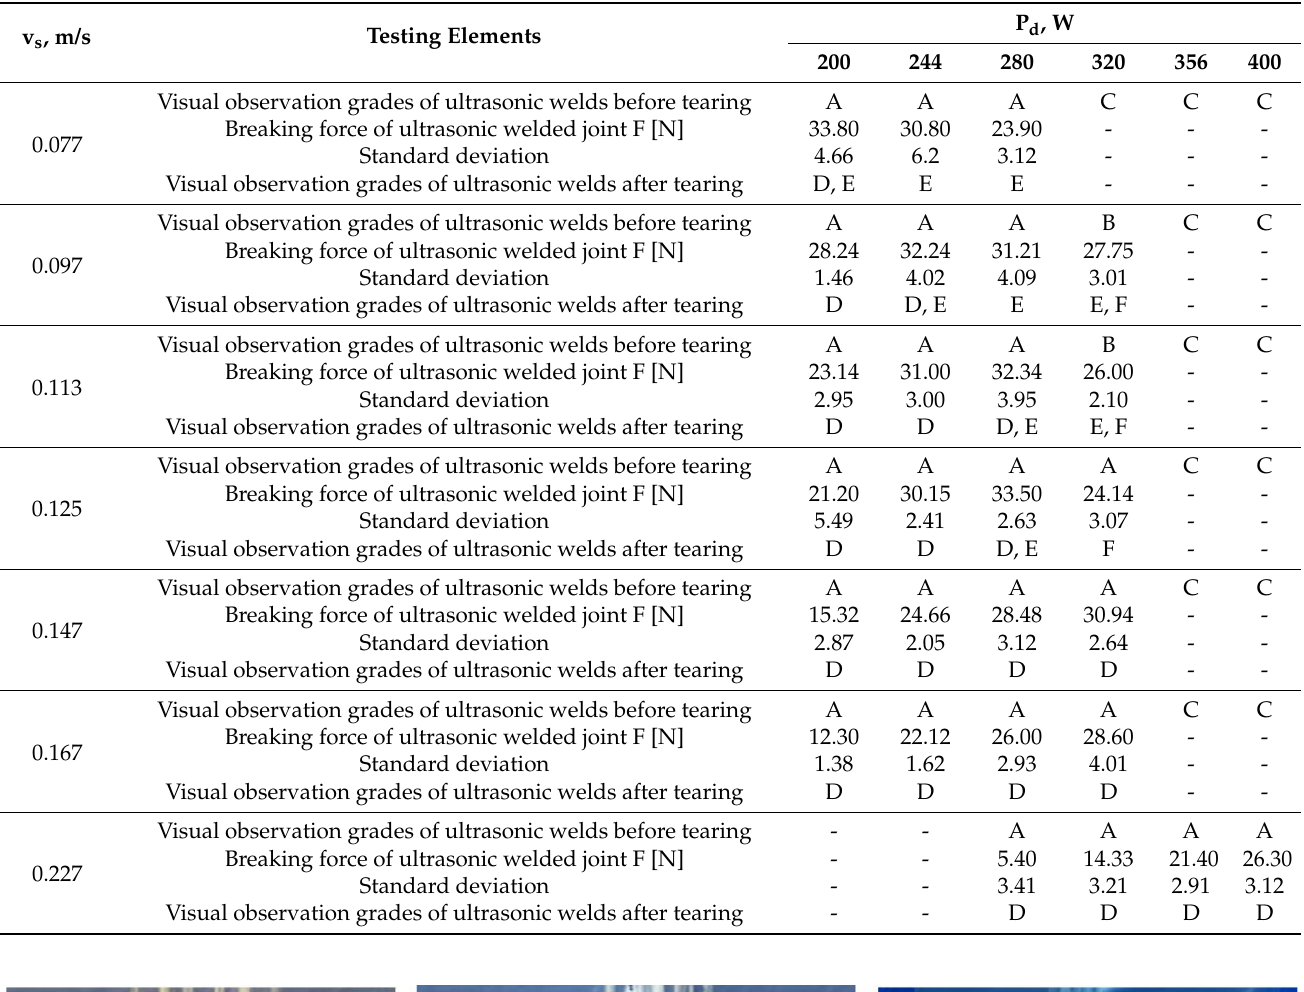
Table 1. The results of breaking force values and standard deviations of specimens of ultrasonic welds and visual observation grades of ultrasonic welds before and after tearing.